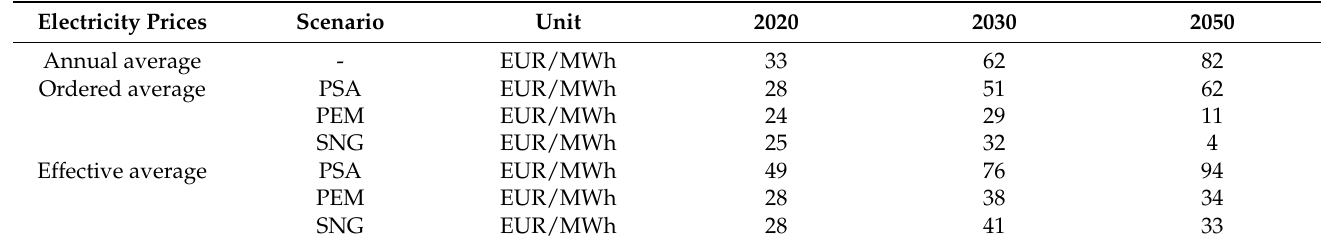
Table 6. Annual, ordered, and effective electricity prices for 2020, 2030, and